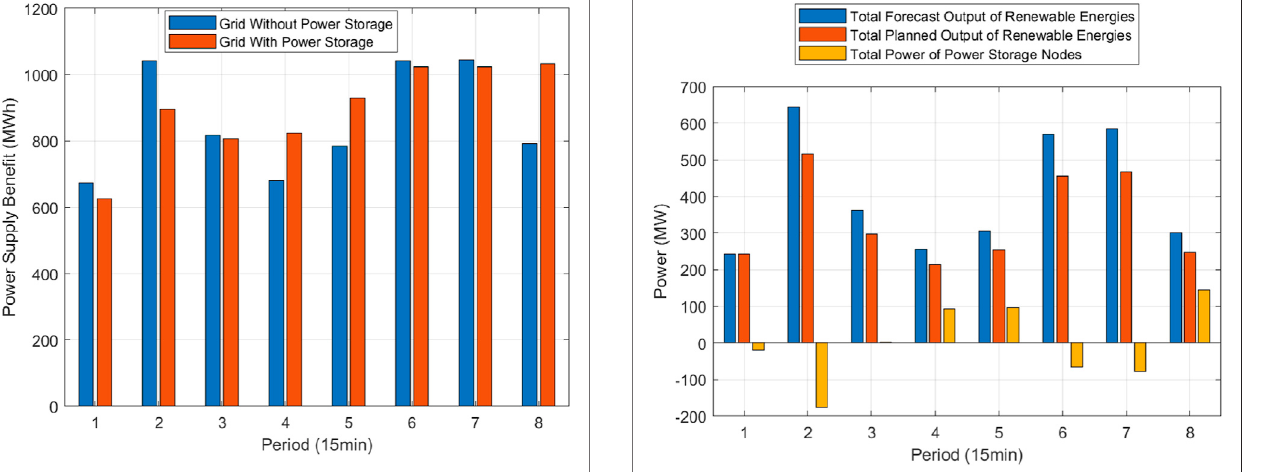
FIGURE 9 | Relationship between the output of renewable energy generator nodes and the power of power storage nodes in each